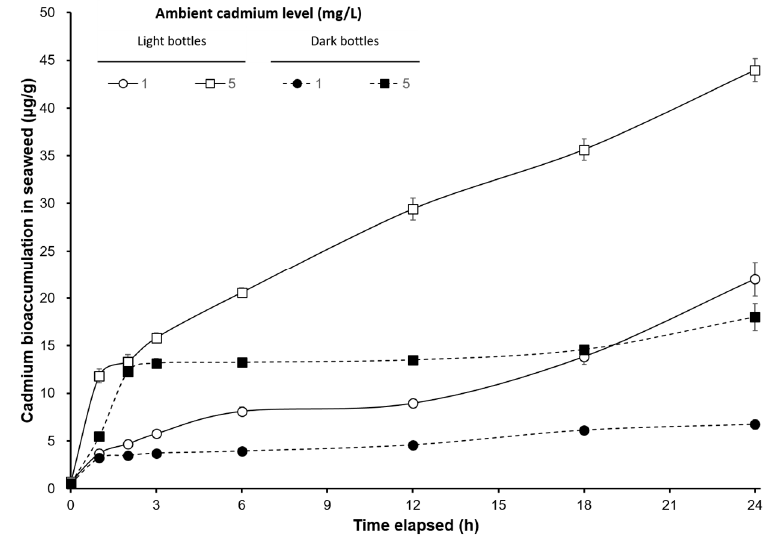
Figure 1. Time-course changes of cadmium bioaccumulation ( µ g / g) on S. suiae under di ff erent cadmium Figure 1. Time ‐ course changes of cadmium bioaccumulation ( μ g/g) on S. suiae under different concentrations (1 and 5 mg / L) exposure in light and dark cadmium concentrations (1 and 5 mg/L) exposure in light and dark bottles.